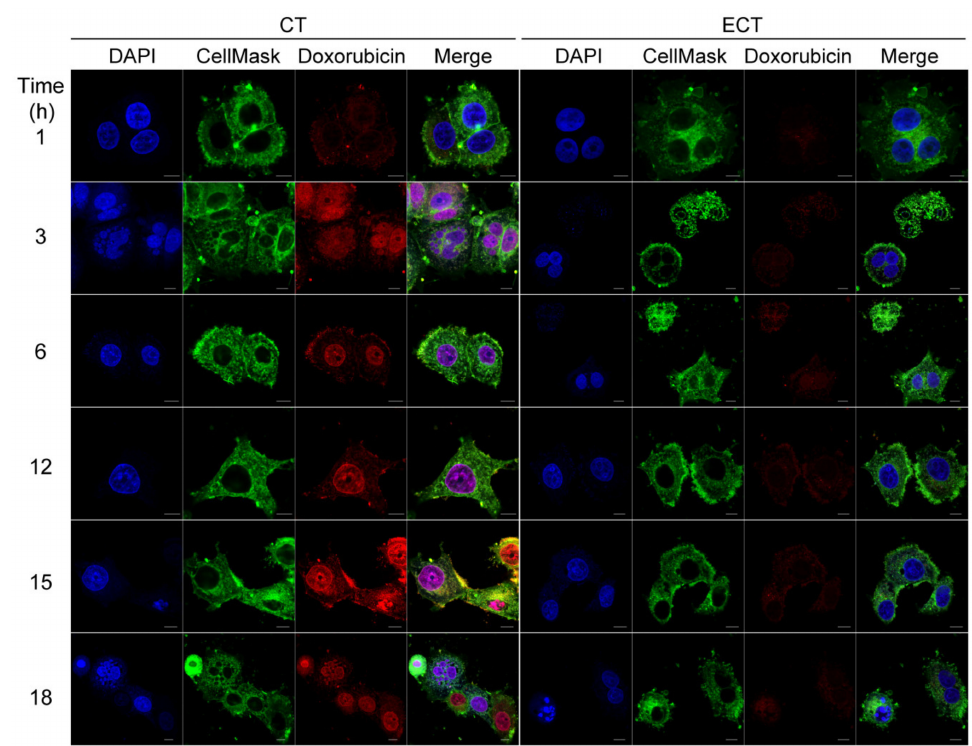
Figure 7. Intracellular distribution of doxorubicin (DOX = 1.7 µ M) in MCF-7 / DOX cells treated with chemotherapy only (CT) or electropermeabilized with DOX (ECT, EP-DOX) (EP = 1000 V / cm, 100 µ s,